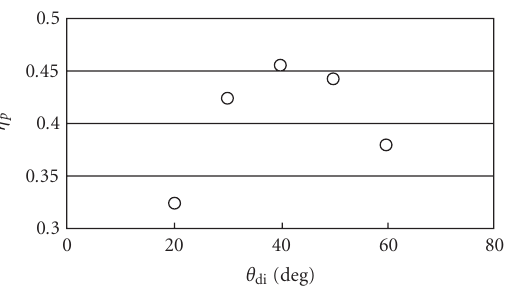
Figure 7: E ff ect of di ff user setting angle of inner guide vane on peak e ffi ciency (inhalation, θ no = 15 ◦